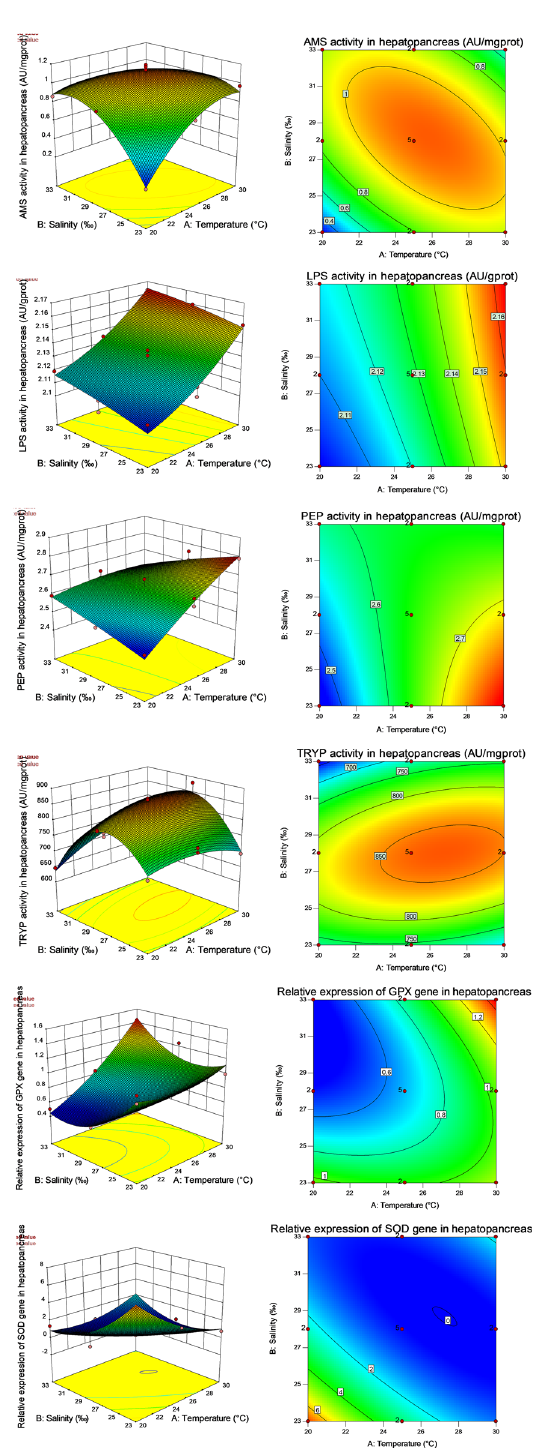
Figure 1. Response surface plots (left) and contour plots (right) of salinity and temperature to digestive enzyme activities and hepatopancreas immune gene relative expression of P. fucata . The activities of AMS, LPS, PEP and TRYP, as well as the relative expression levels of GPX and SOD genes in hepatopancreas were shown from top to bottom. The heat map in Fig. 1 was generated using Design Expert (https:// www. state ase. com/ softw are/ design- expert/, version 10.0.7.0 32-bit)